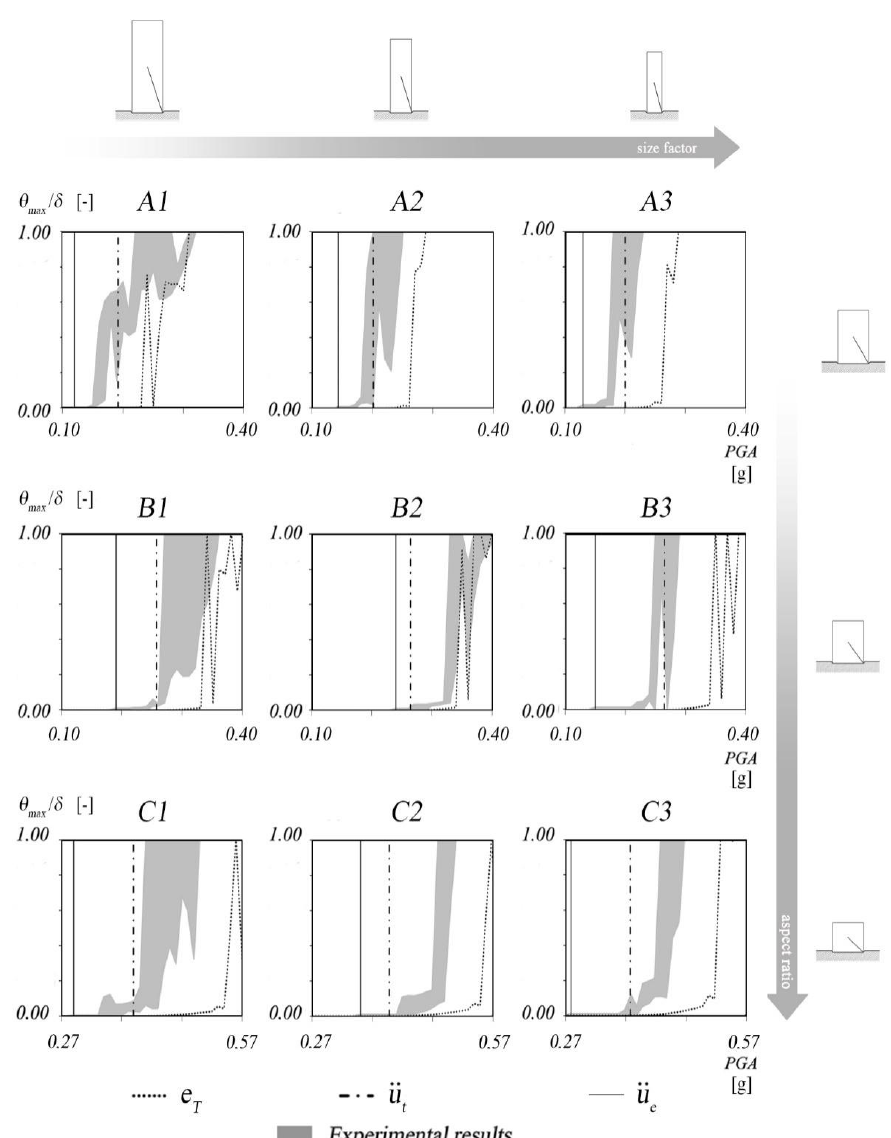
Figure 17. Comparison between experimental and numerical maximum rotation variability graph using the coefficient of restitution as proposed by Housner.